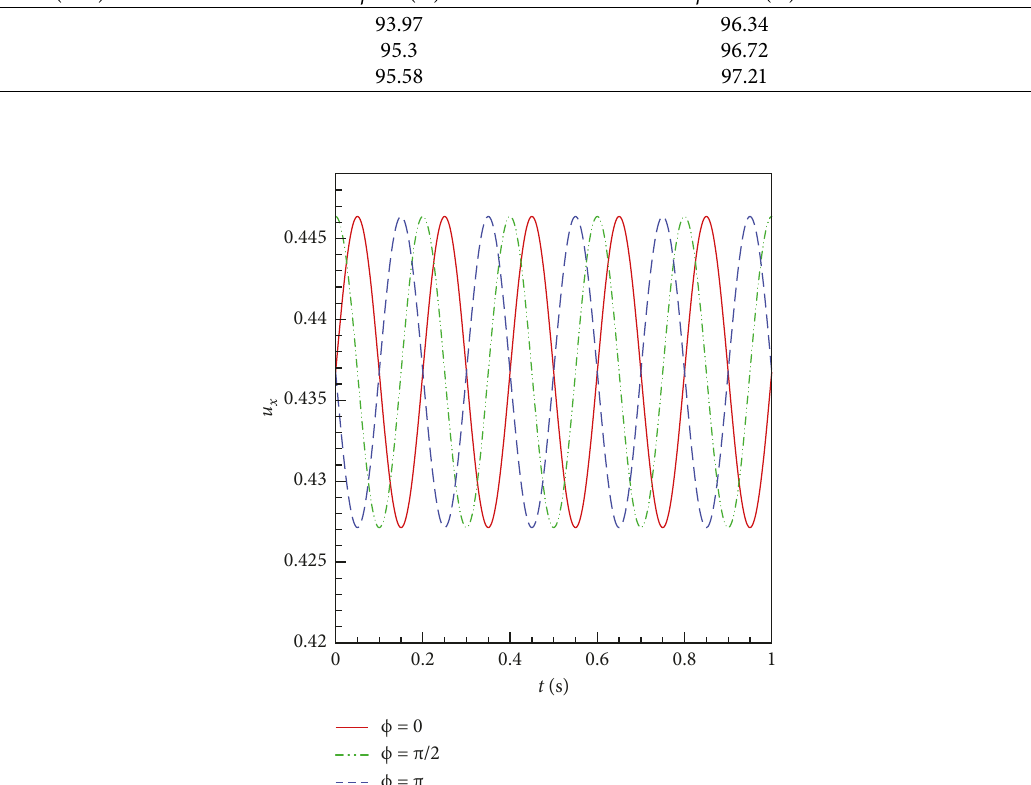
Figure 10: Velocity variations in the hexagonal inlet at f � 5 Hz and u � 0.2 mm · s − 1 for three phase difference levels (0, π /2, and π ).